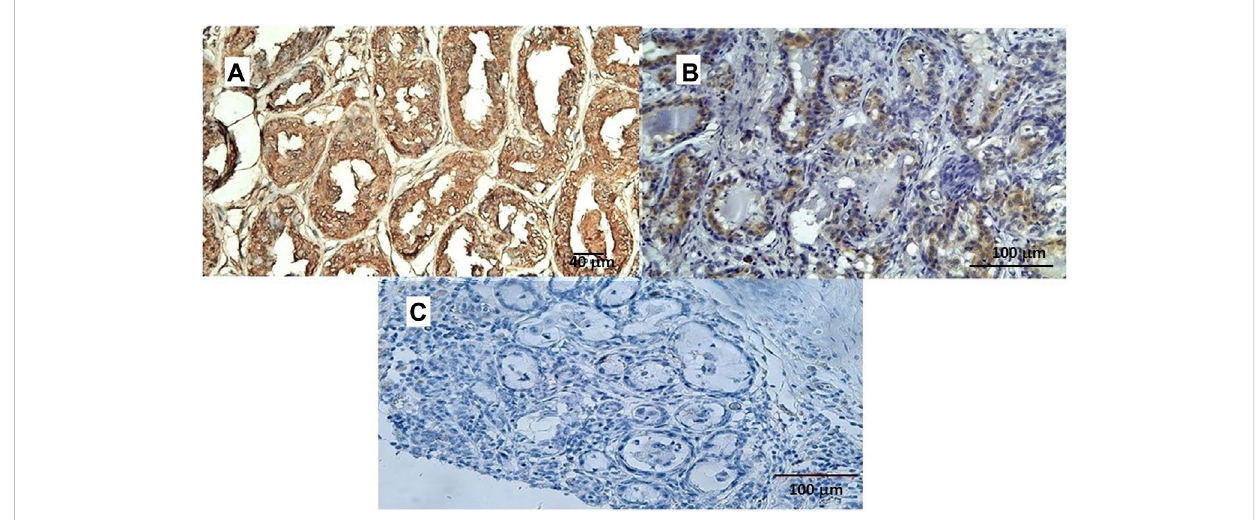
FIGURE 5 (A) Sur2AimmunohistochemicalreactionlocalizedinthecytoplasmandplasmamembraneofcaninefemalebreastcancercellsinG3.Bar=40 μ